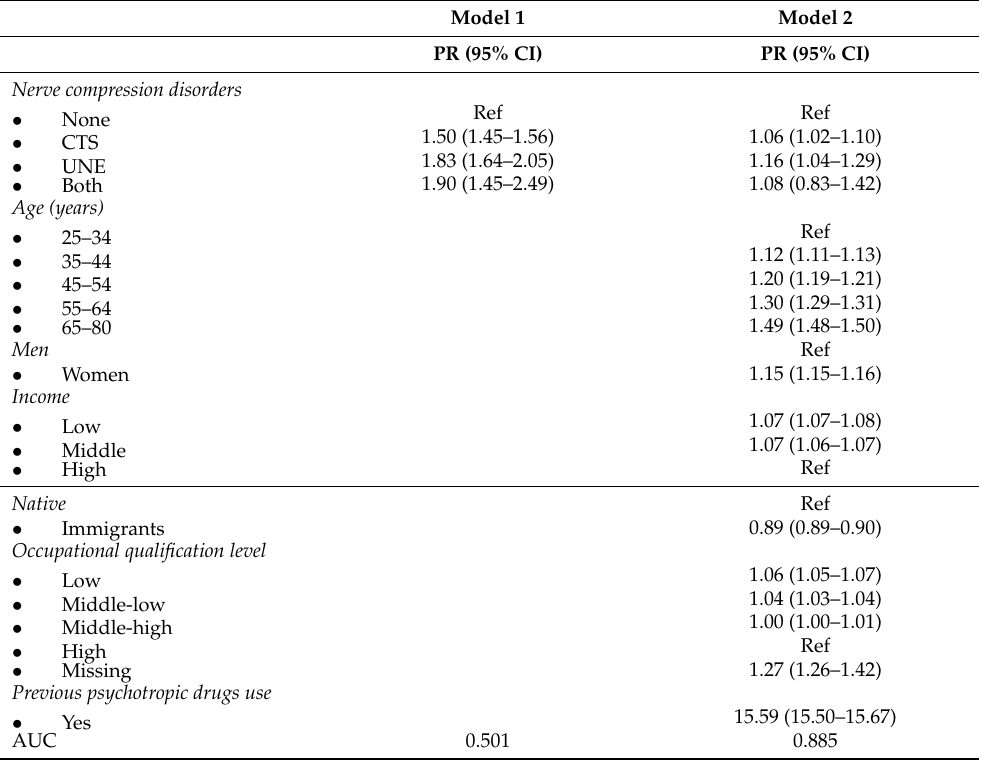
Table 2. Crude (Model 1) and adjusted (Model 2) for demographical and socioeconomic factors association between the existence of diagnosed and surgically treated carpal tunnel syndrome (CTS), ulnar nerve entrapment (UNE), or both and use of psychotropic drugs during the follow-up in the 5,751,152 individuals aged 25–80 residing in Sweden by 2010. Values are prevalence ratios (PR) and 95% confidence intervals (CI).